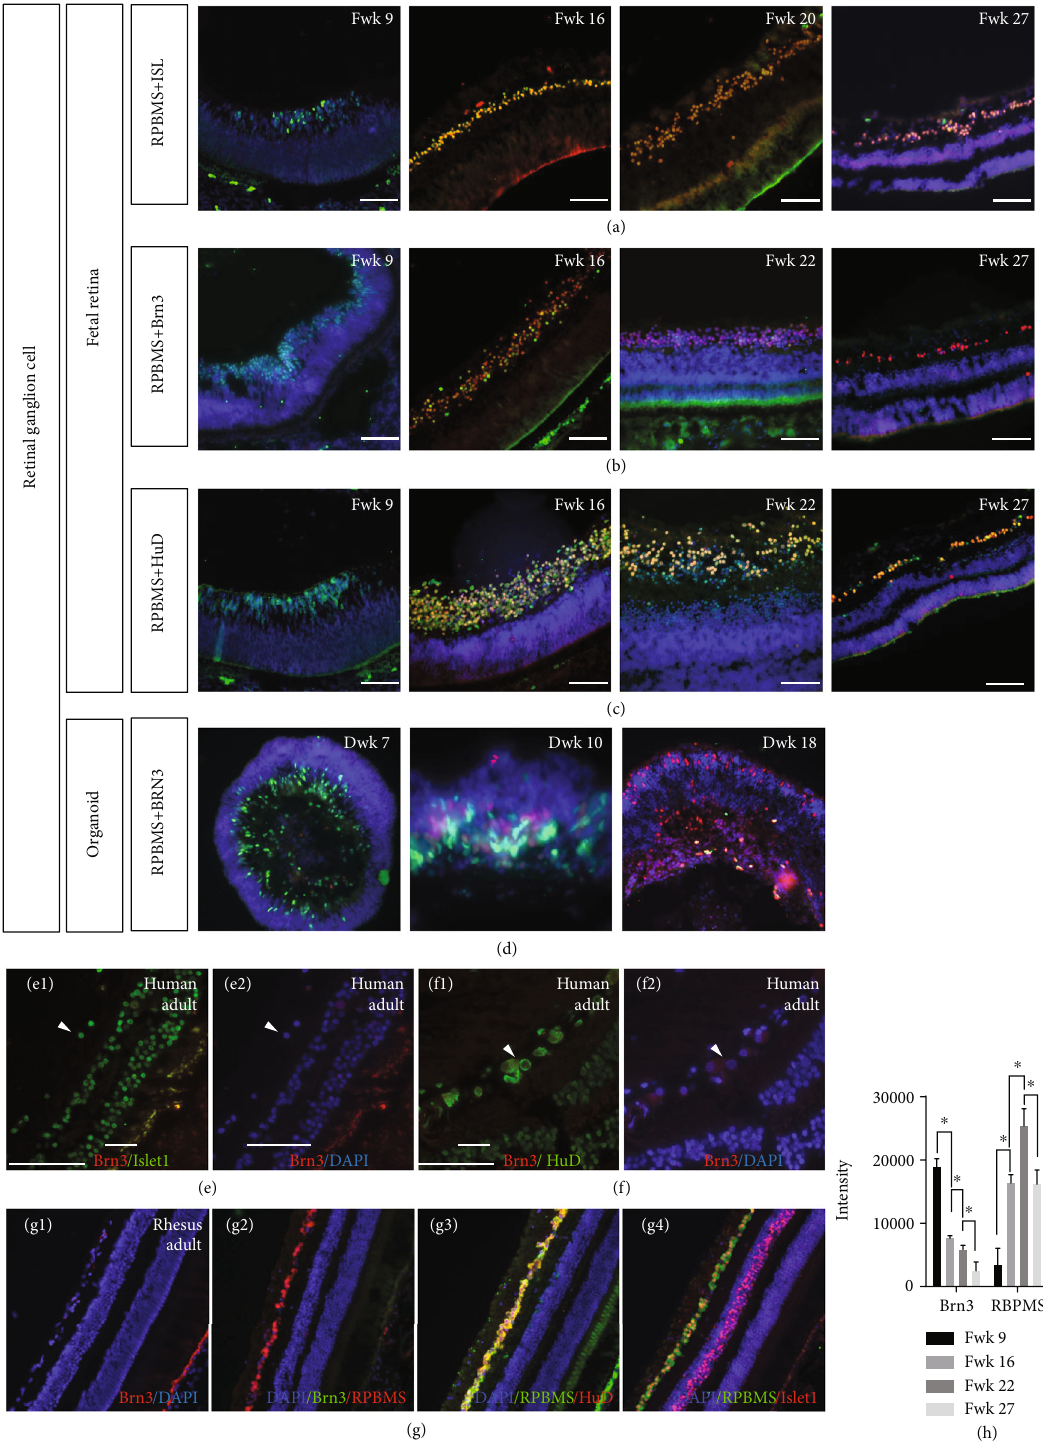
Figure 4: Colabeling RGC with RBPMS, ISL, and Brn3 in human fetal retina, retinal organoid, and rhesus retina. (a) Colabeling RGC with RBPMS and Islet1 in fetal retina. (b) Costaining fetal retina with RBPMS and Brn3. (c) Double staining of HuD and RBPMS in fetal retina. (d) RPBMS expression shared the same pattern in retinal organoids. (e1, e2) In the human adult retina, Islet1 was expressed in retinal ganglion cells (white triangle) but these cells were Brn3 negative. (f1, f2) Human adult ganglion cells were HuD positive (white triangle) but Brn3 negative. (g1) No Brn3-positive cells were detected in rhesus retina. (g2) Retinal ganglion cells were RPBMS positive but could not been stained by Brn3 antibody. (g3) HuD antibody stained retinal ganglion cells along with RBPMS. (g4) Islet1 was positive in both GCL and INL, but RPBMS only labeled retinal ganglion cells. (h) Brn3 immuno fl uorescence intensity on human fetal retina, along with RBPMS. Scalebar = 100 μ m